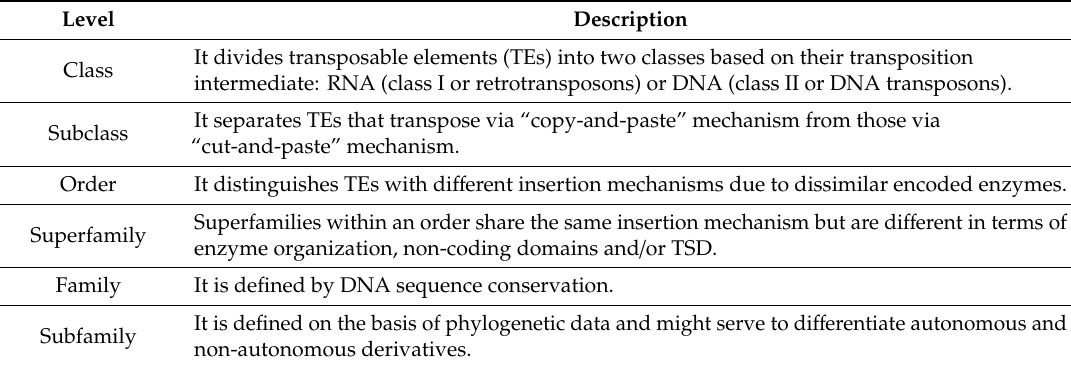
Table 1. The hierarchical classification of transposable